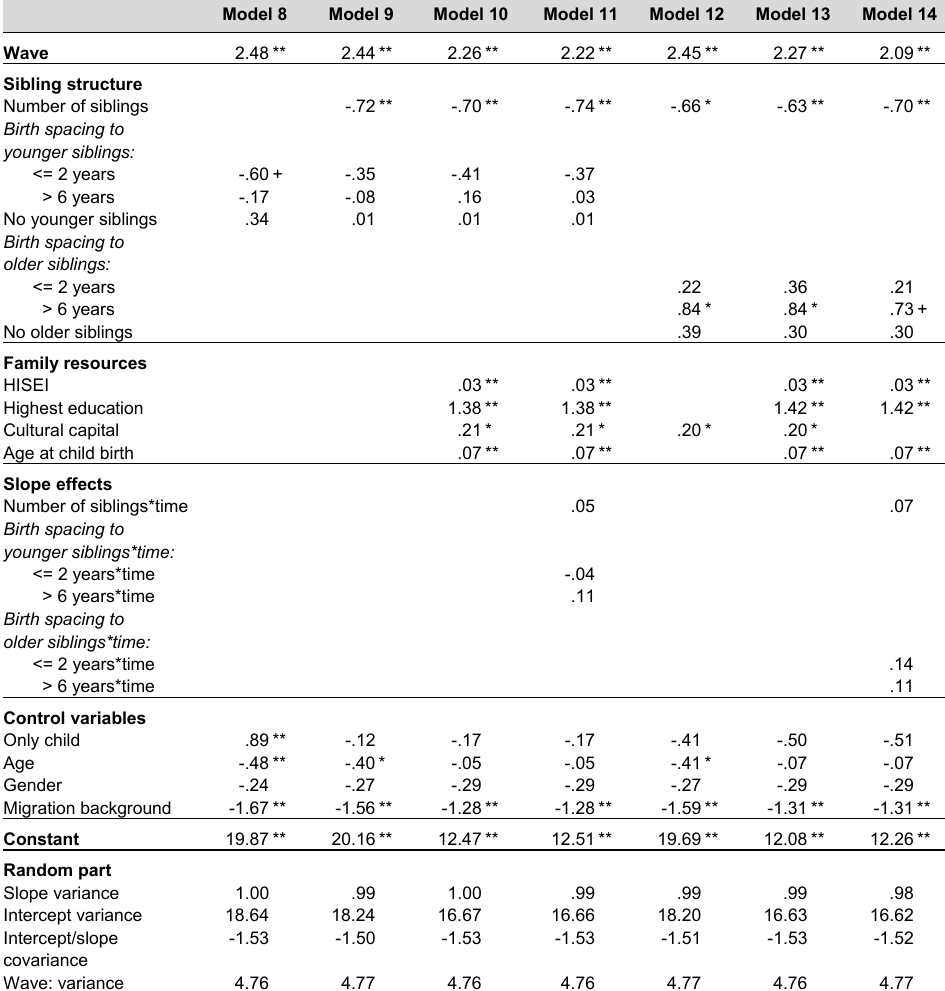
Table 3 : Linear latent growth curve models (LGMs) on vocabulary test scores (Wave 1-3): Birth spacing Model 8 Model 9 Model 10 Model 11 Model 12 Model 13 Model